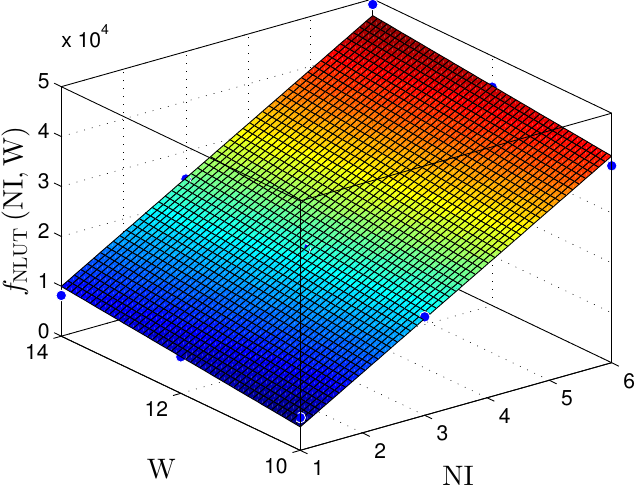
Figure 22. Plane, f NLUT ( NI , W ) , found to estimate the number of LUTs, NLUT, as a function of the number of implementations, NI, and the number of bits in fractional part W for RMLP-based prediction